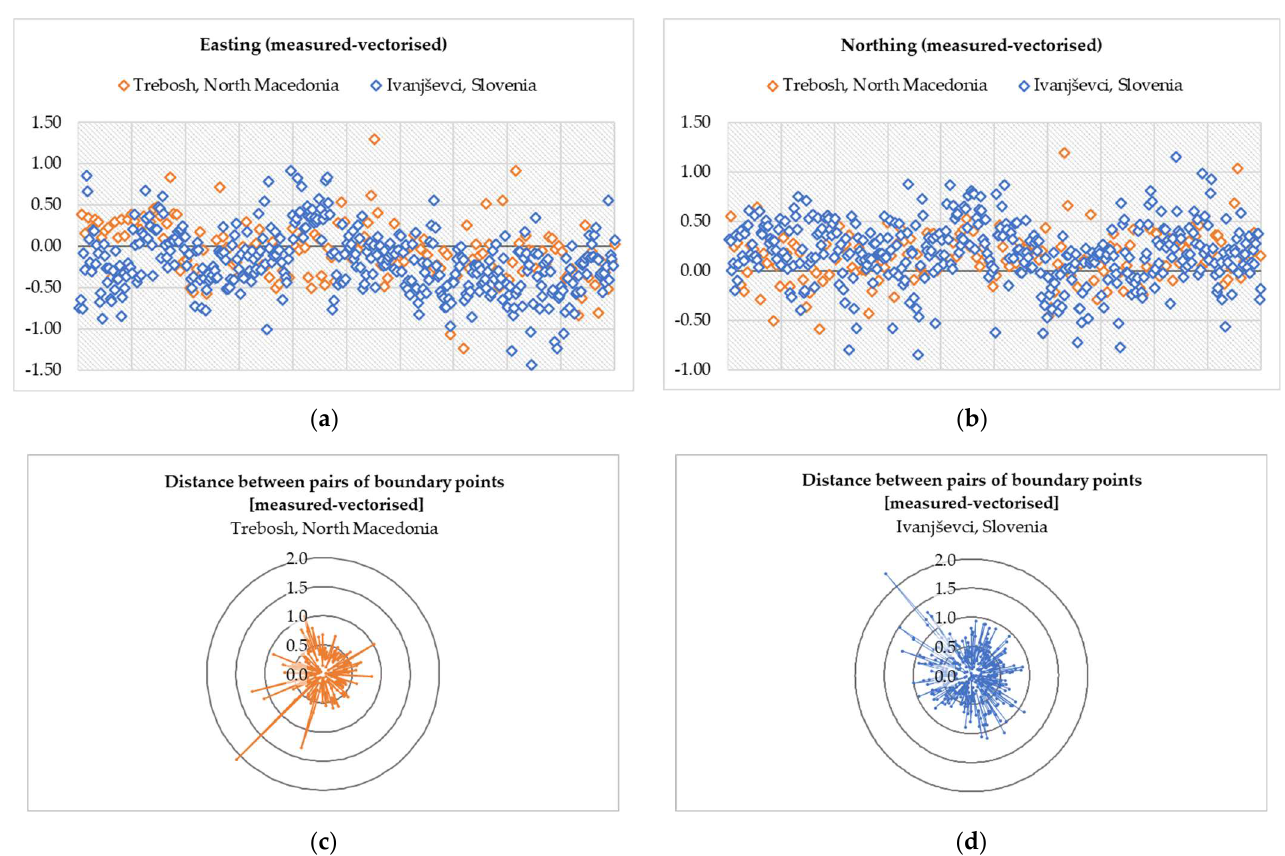
Figure 10. ( a , b ) Coordinate differences (easting and northing) for boundary points in cadastral district Trebosh, North Macedonia, and ( c , d ) distance—based analysis between pairs of boundary points calculated from measurements and obtained from vectorisation.